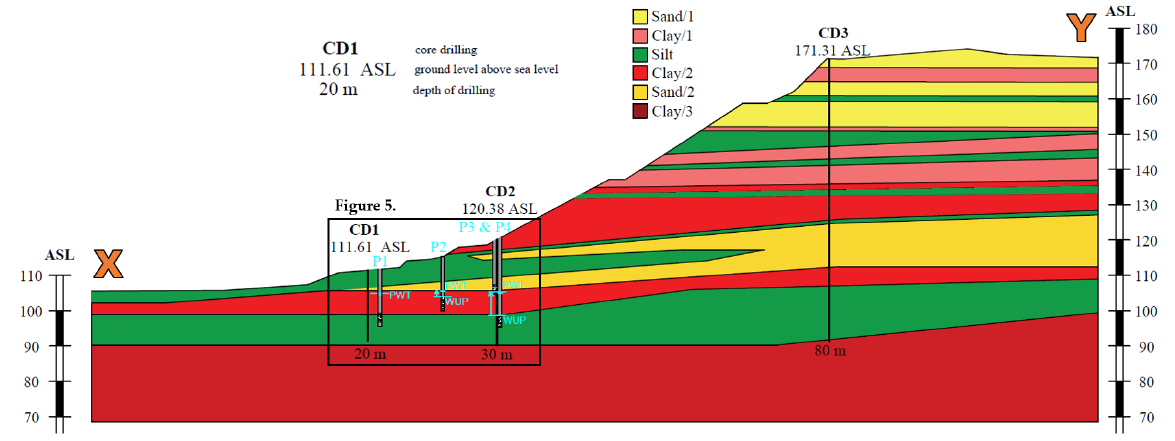
Figure 4. X–Y cross section with core drillings and Casagrande piezometers.